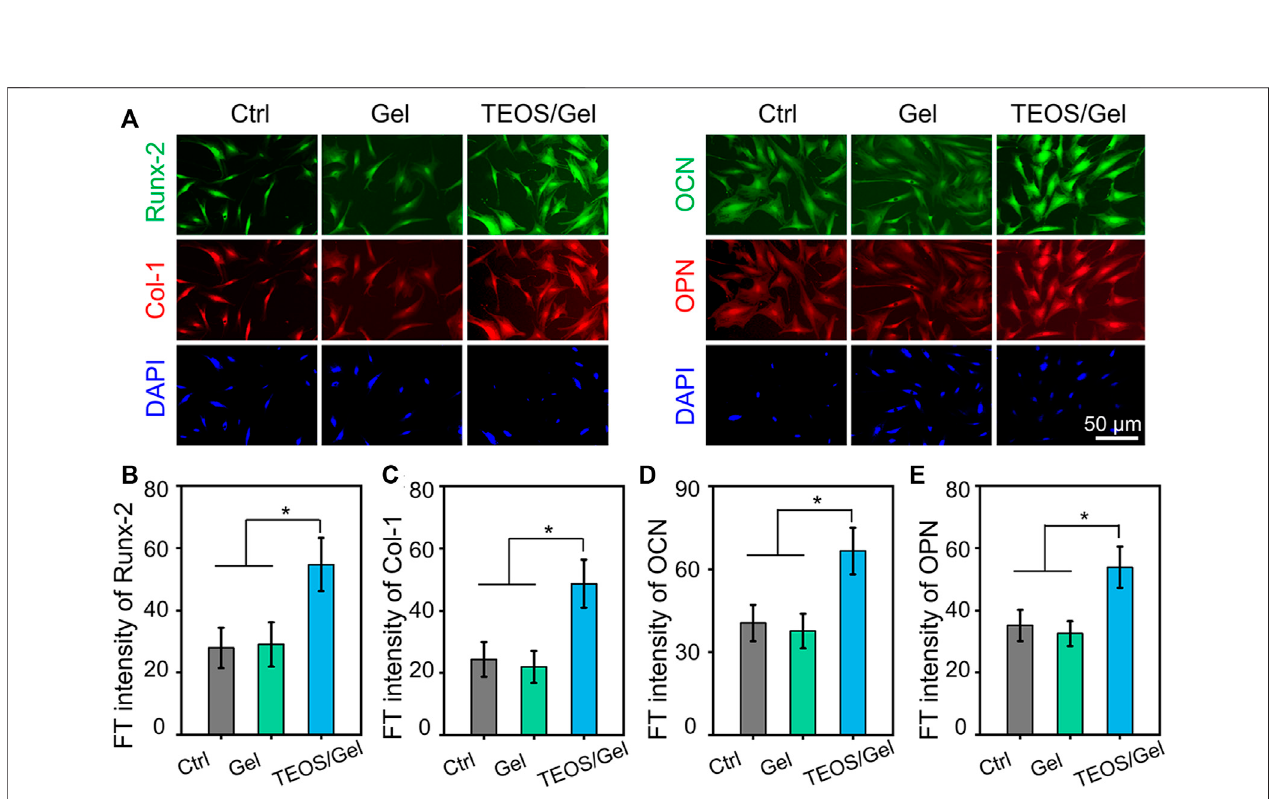
FIGURE 4 | TEOS hydrogel induces BMSC osteogenic differentiation at the protein level. (A) Double immuno fl uorescent staining of cartilage-speci fi c markers Runx-2, Col-1, OCN, and OPN in BMSCs after osteogenic induction for 21 days. (B – E) Quantitative analysis of the immuno fl uorescence intensity of Runx-2, Col-1, OCN, and OPN (* p <